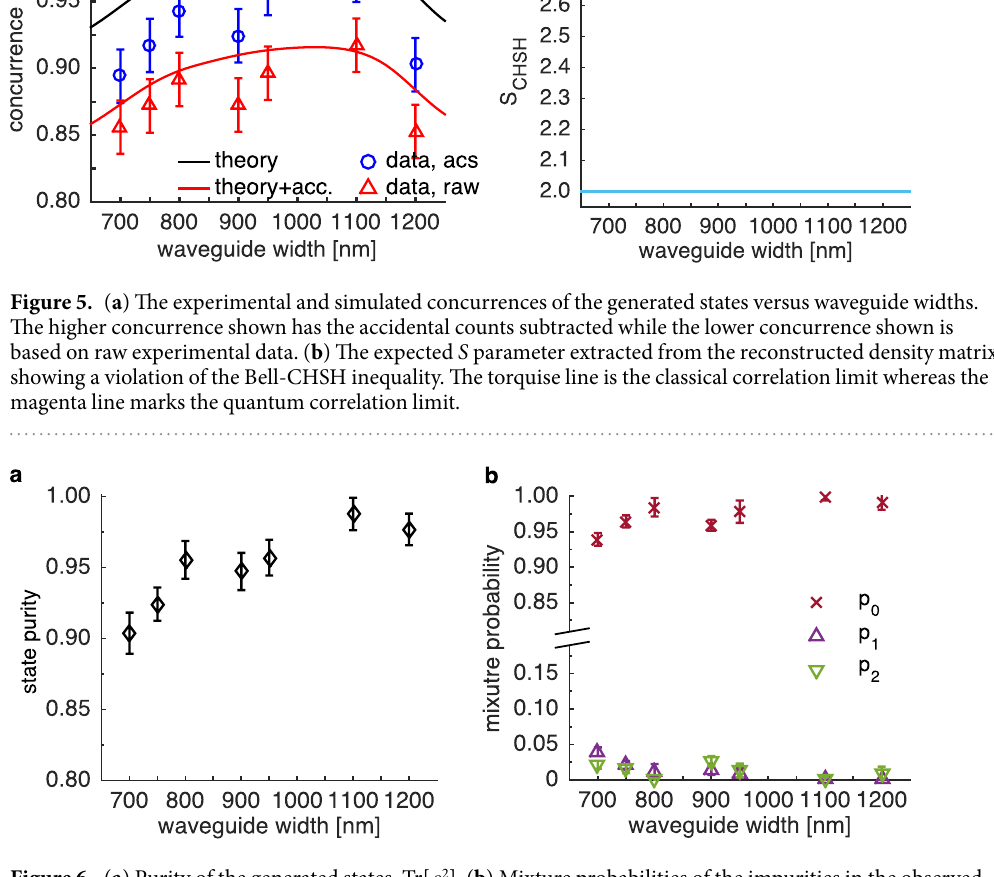
Figure 6. ( a ) Purity of the generated states, Tr[ ρ 2 ]. ( b ) Mixture probabilities of the impurities in the observed density